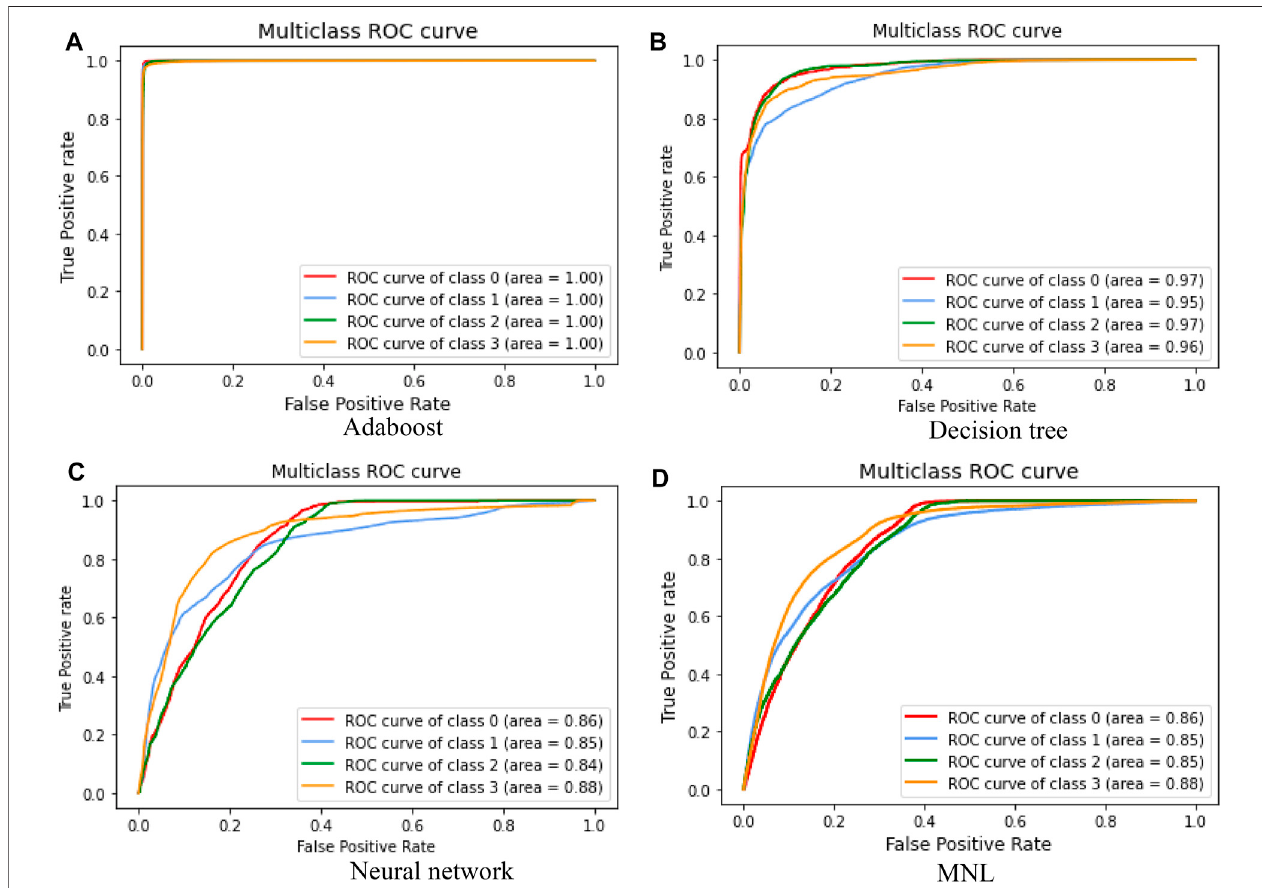
FIGURE 10 | ROC curve for different models and different classes. Class 0 (Car sharing): Class 1 (Private car): Class 2 (Regular bus): Class 3 (regulat taxi). (A) Adaboost (B) Decision tree (C) Neural network (D) MNL.